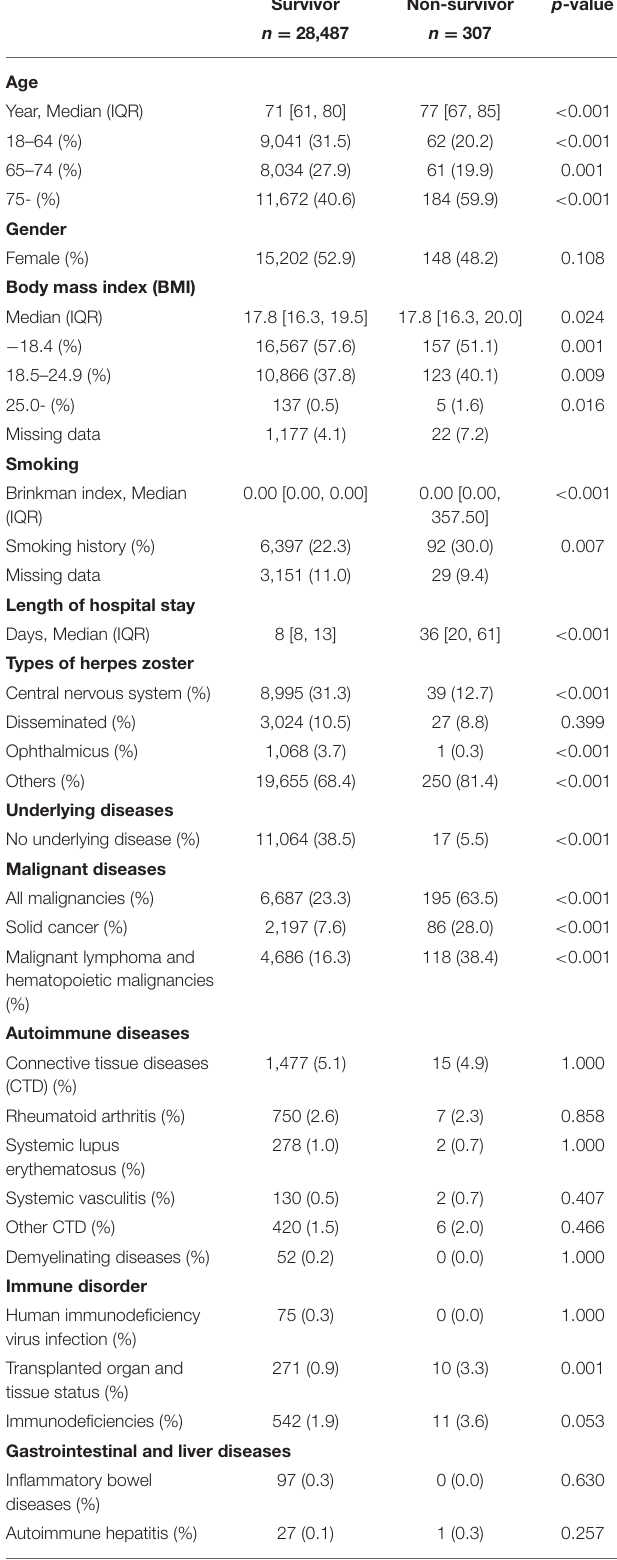
TABLE 2 | Baseline clinical characteristics between survivors and